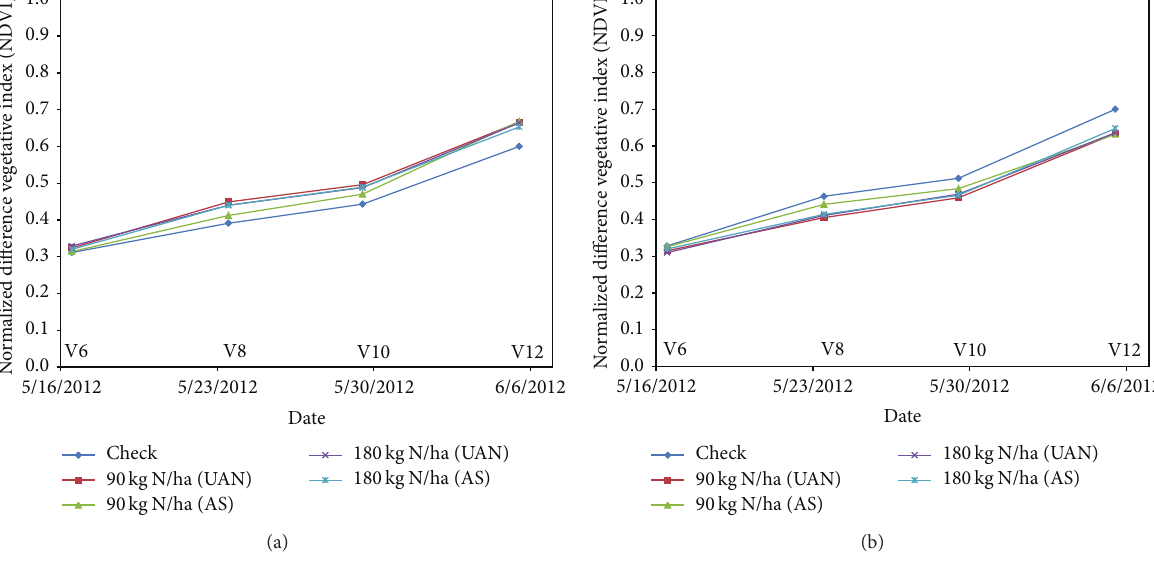
Figure 2: Normalized difference vegetative index (NDVI) values by maize growth stage for irrigated (a) and rain-fed (b) fertilizer treatments at Lake Carl Blackwell, OK